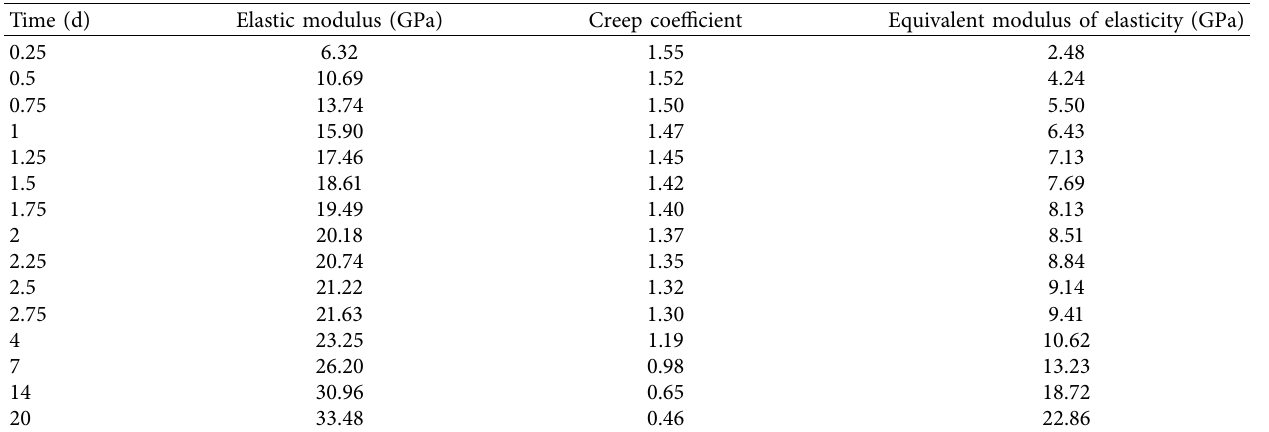
Table 6: The time effect parameters of